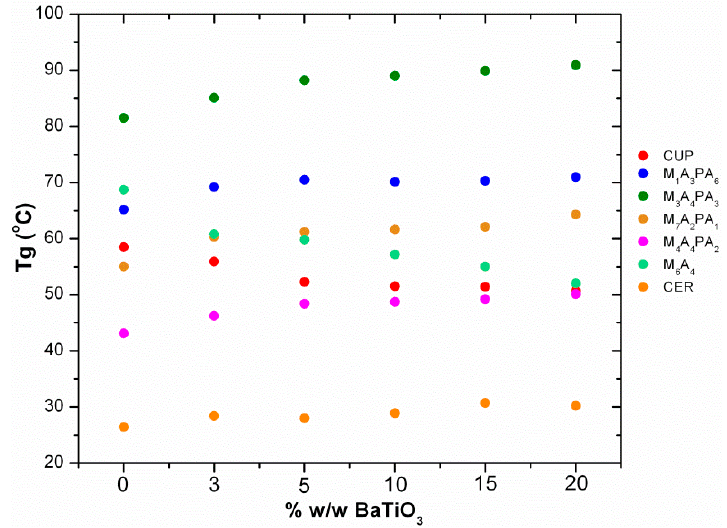
Figure 5. Glass transition temperature (Tg) for all of the developed nano-composite specimens.